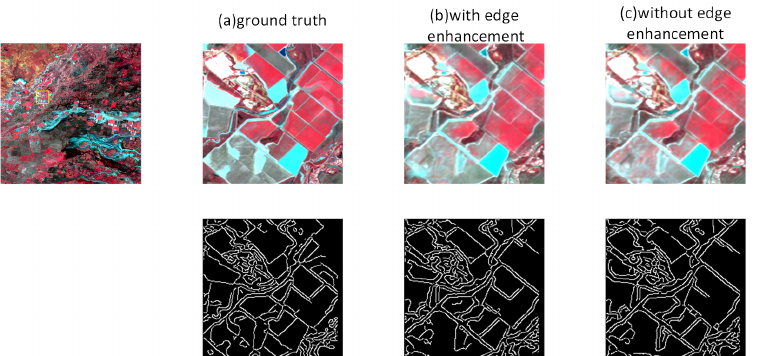
Figure 15. This figure shows the local results with edge enhancement on the LGC dataset and their corresponding edge images. These color figures exhibit the false color composite images using band 4, band 3, and band 2.